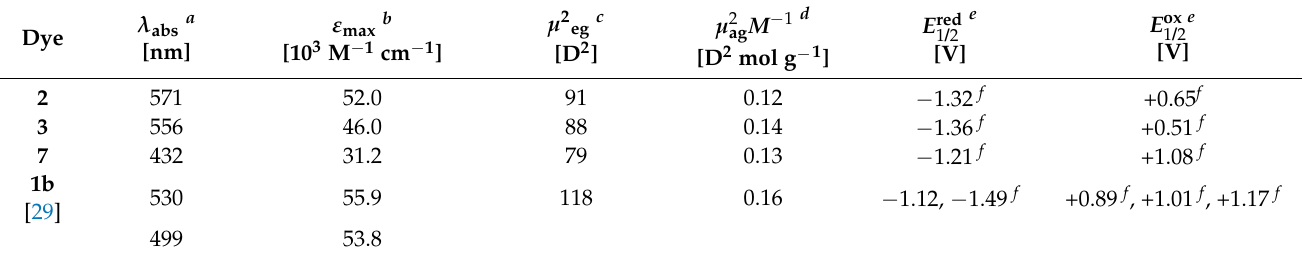
Figure 2. UV/Vis absorption spectra of dyes 2 , 3 , 7 , and 1b (solid lines) measured at c ~ 10 − 5 M in CH 2 Cl 2 and fluorescence spectra of 2 and 3 (dashed lines) determined in CH 2 Cl 2 by optical dilution method (OD < 0.05).